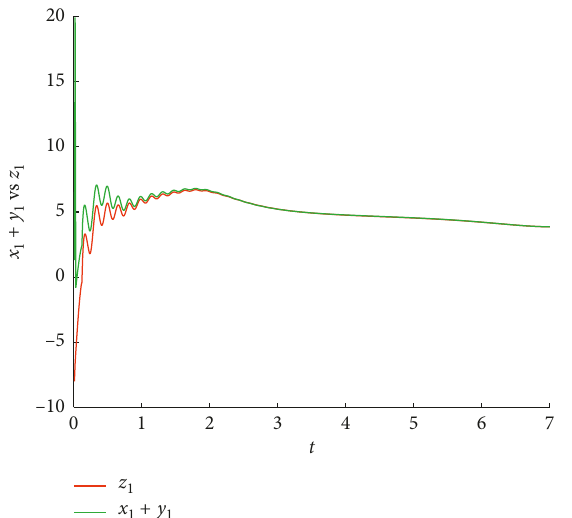
Figure 7: Time responses for state x